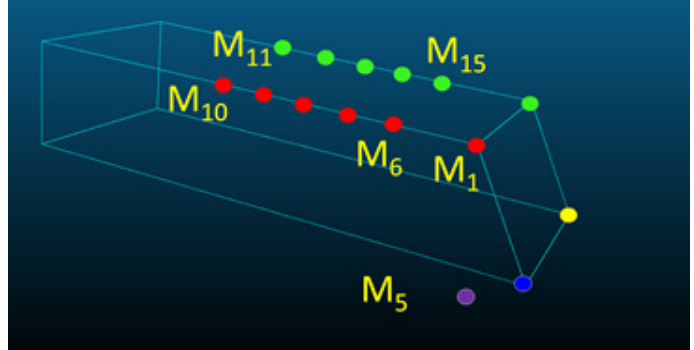
Figure 15. Example of 5 3D points sampled for each corner along the long axis of a cargo box.